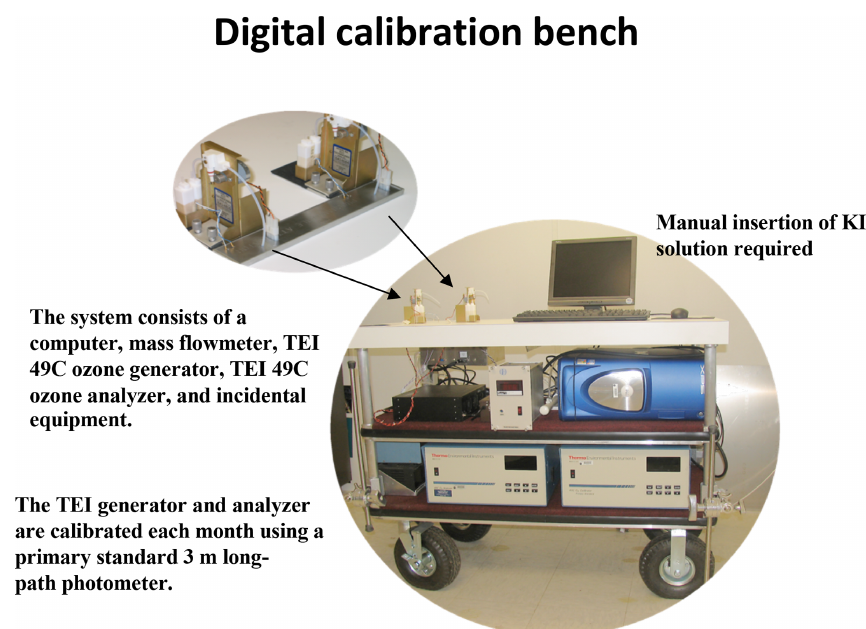
Figure 1. Digital calibration bench showing operational configuration and mounting position of two ECC ozonesondes. Major components include the ozone generator and analyzer, computer, flowmeter, and glass